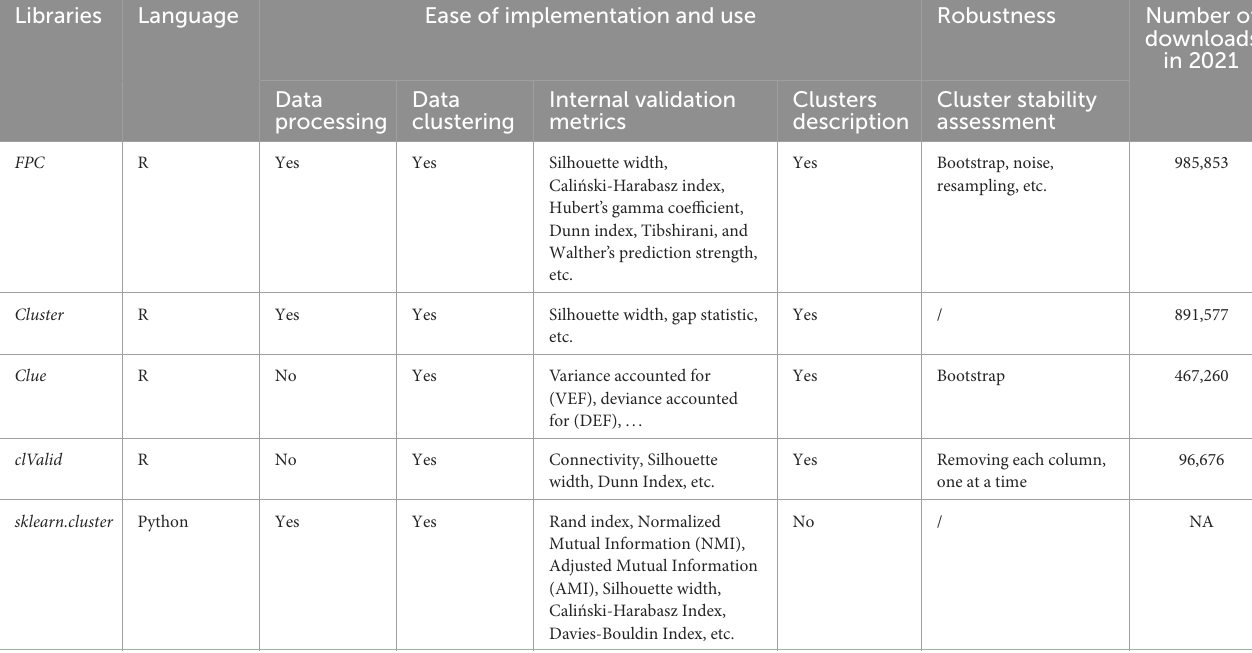
TABLE 1 Description of selected software